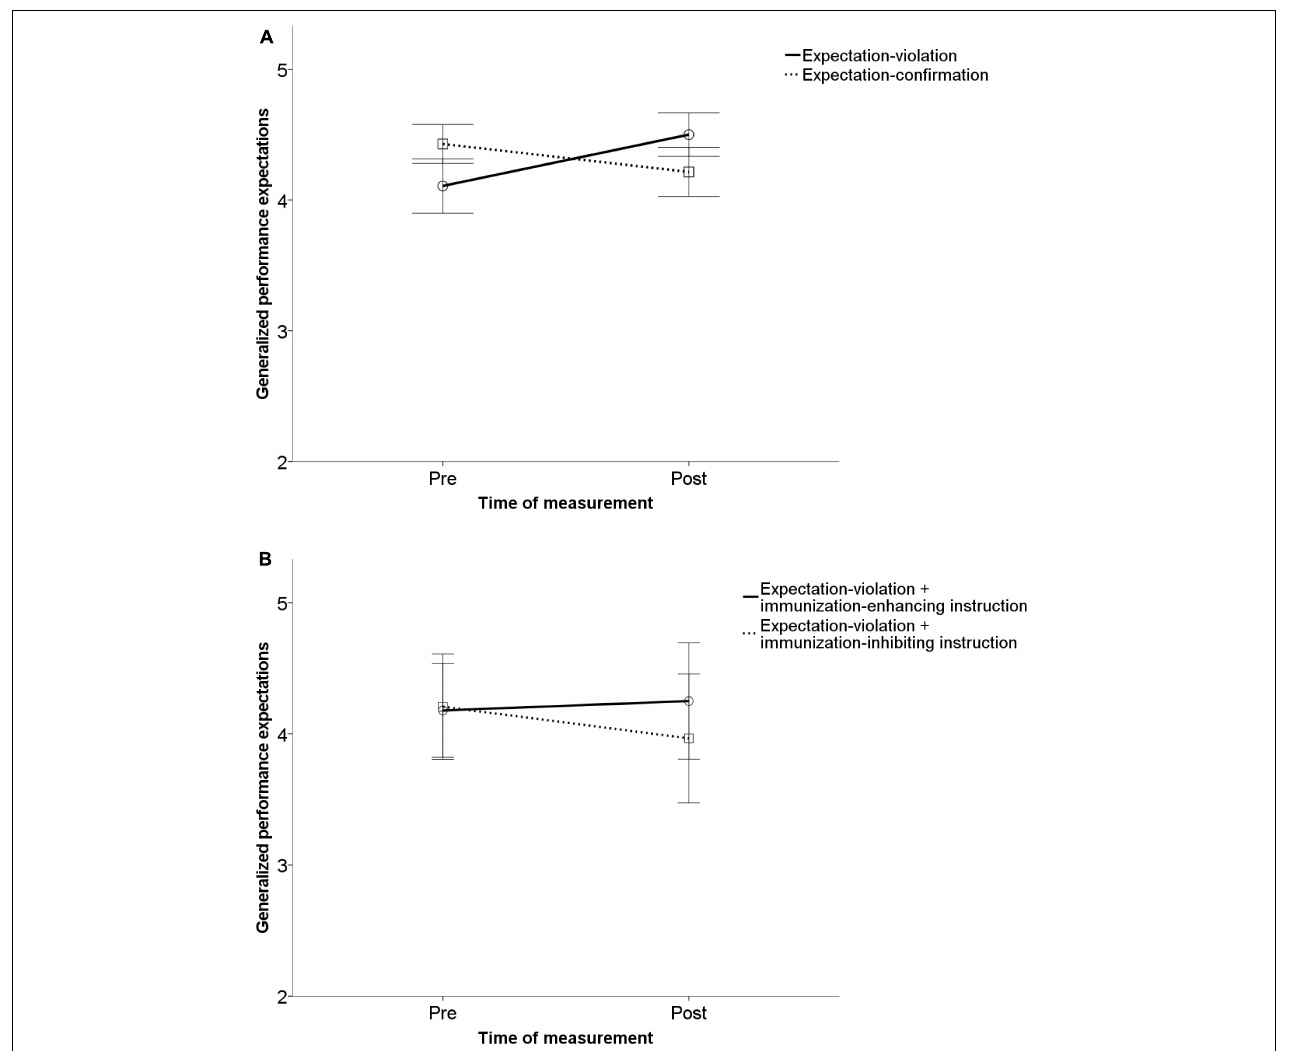
FIGURE 3 | Illustration of the main results for generalized expectation change. Experiment 1 (A) : Results indicated that after receiving expectation-confirming performance feedback, participants did not change their generalized performance expectations significantly. In the expectation disconfirmation condition, participants significantly changed their generalized expectations. Experiment 2 (B) : No significant change of generalized expectations occurred after immunization-inhibiting or -enhancing instructions. The error bars represent one standard